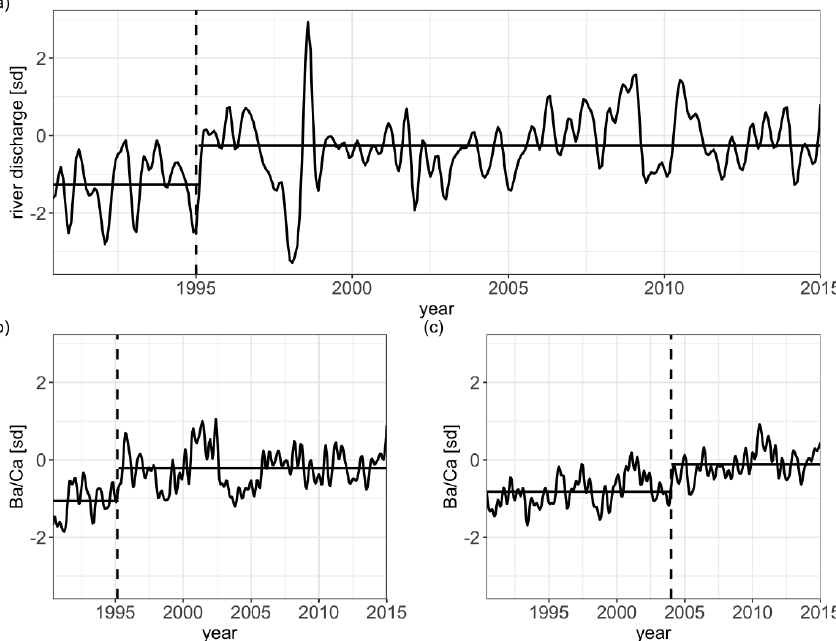
Figure 6. Change point analysis (MATLAB, 2022) based on significant arithmetic mean change for (a) Marudi station’s discharge as well as both composite records, (b) C1, and (c)